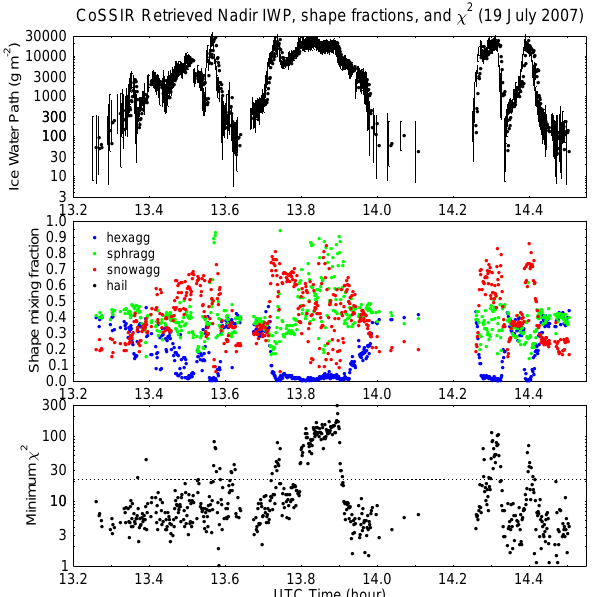
Fig. 10. Nadir retrievals of ice water path with error bars (top panel), shape mixing fractions (middle panel), and minimum χ 2 (bottom panel) for the retrieval with four particle shapes.